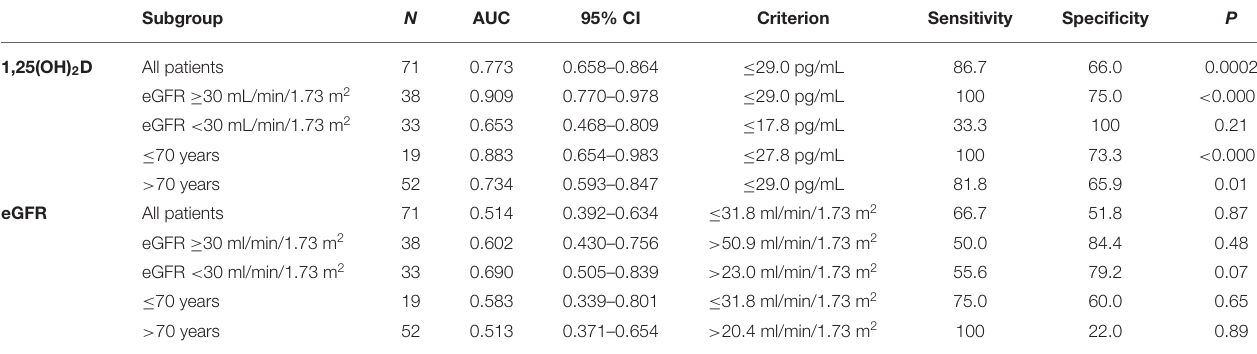
TABLE 4 | ROC analysis for predicting WRF ≥ 20% at 6 months.